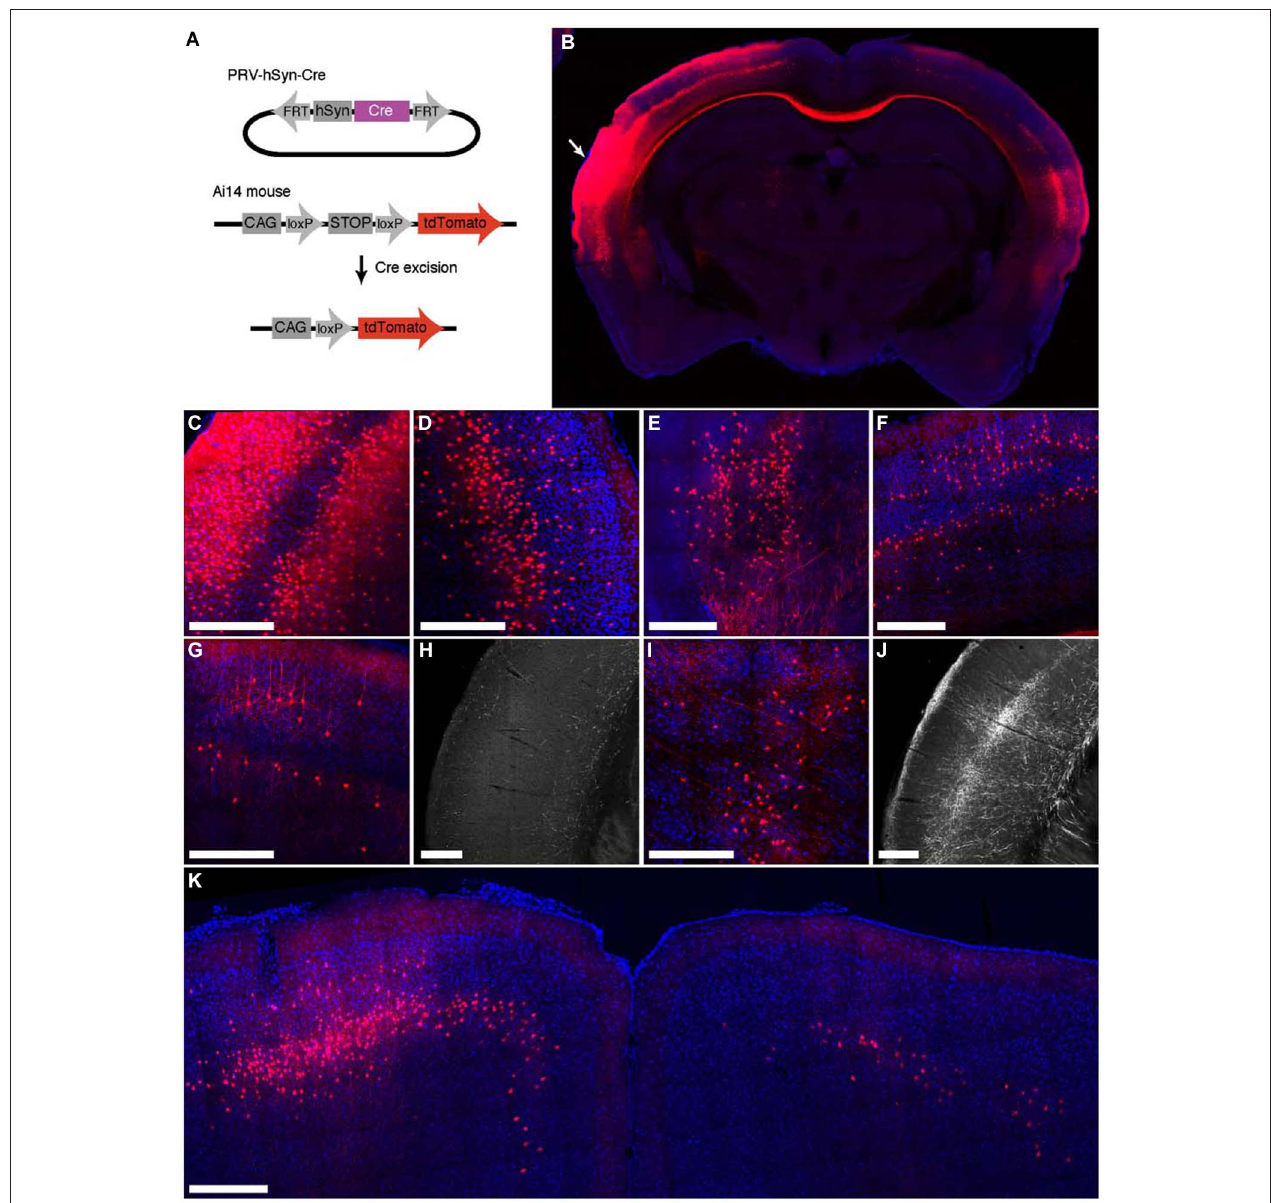
parietal cortex, (G) contralateral parietal cortex, (I) the lateral posterior and the posterior nuclei in the thalamus and (K) motor cortex. (H) Axonal labeling in the primary auditory cortex of a mouse injected with AAV-EGFP in the contralateral parietal cortex, adapted from Allen Mouse Brain Connectivity Atlas. (J) Axonal labeling in the primary auditory cortex of a mouse injected with AAV-EGFP in the ipsilateral posterior and lateral posterior nuclei. Scale bars—300